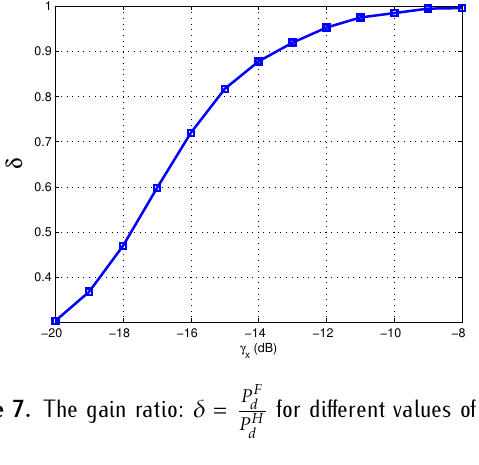
Figure 7. The gain ratio: δ =